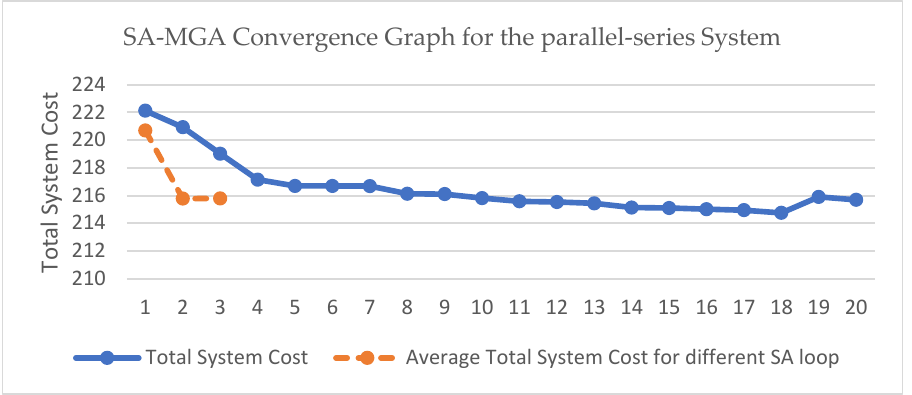
Figure 10. The convergence graph of the parallel-series system by employing the SA-MGA com- bined method.